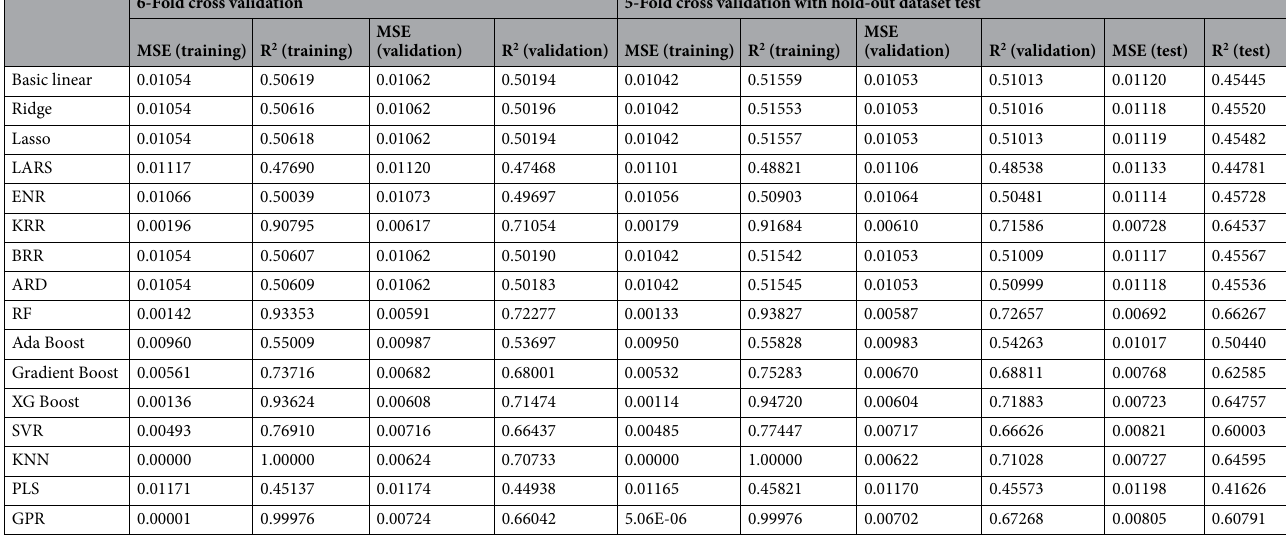
Table 1. The training, validation and hold-out dataset test results in terms of MSE and R 2 for two data- splitting schemes: 6-fold cross-validation (with no holdout dataset test) and 5-fold cross-validation with a holdout test